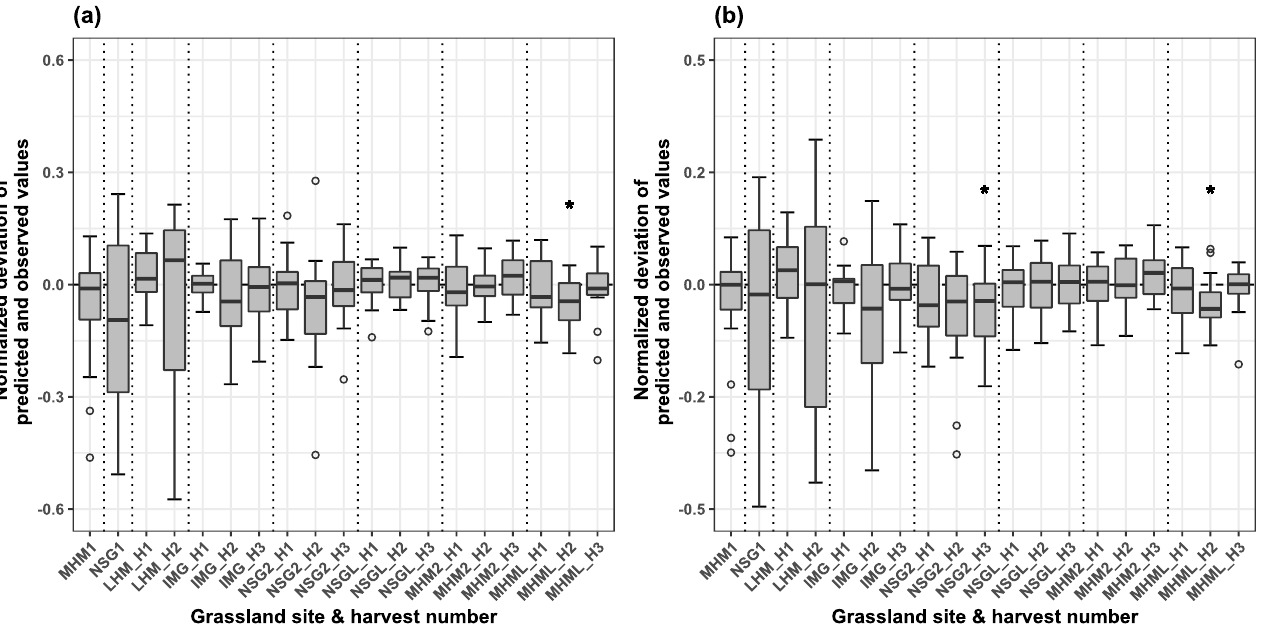
Figure 7. Normalized deviations of predicted from observed values based on the final selected Cubist model for ( a ) fresh and ( b ) dry biomass yield. Harvest numbers are given after the grassland suffix by “H1–H3”. Different harvests of one grassland are arranged between dotted vertical lines. Significant differences (α = 0.05) in the mean deviation for each grassland from zero based on the Wilcox-test are indicated by a star (*).